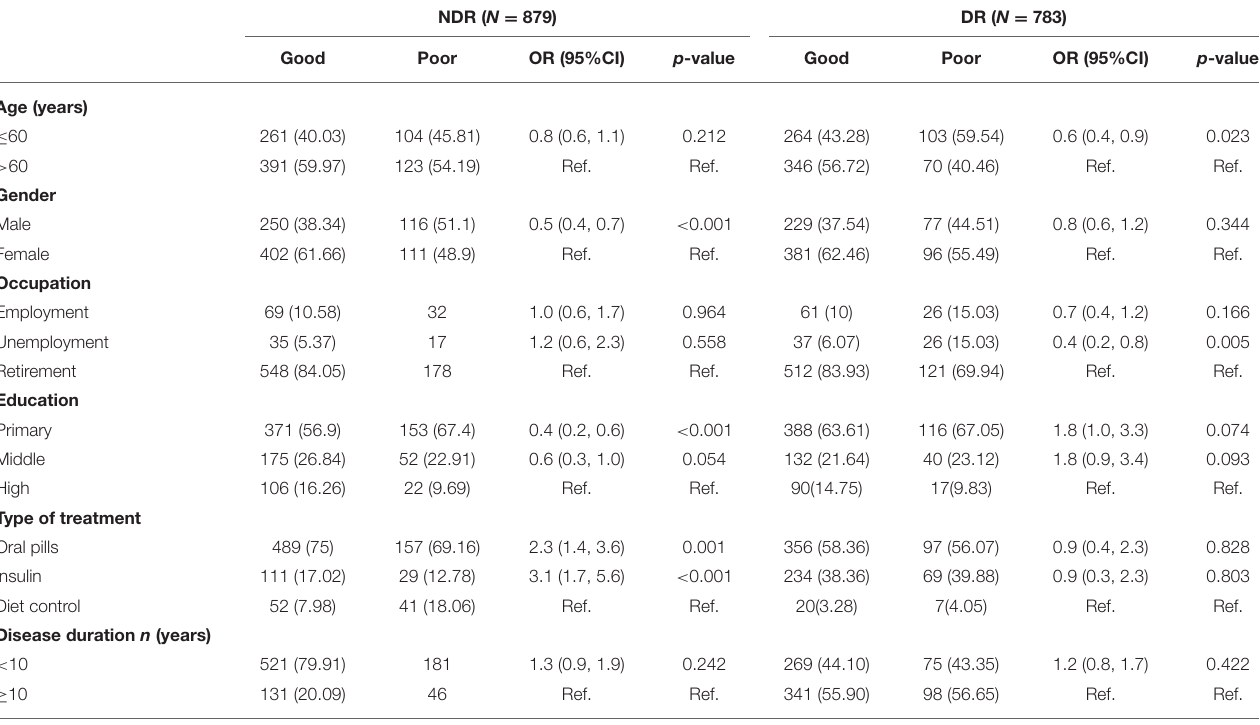
TABLE 4 | Multivariate logistic regression of good practice in NDR and